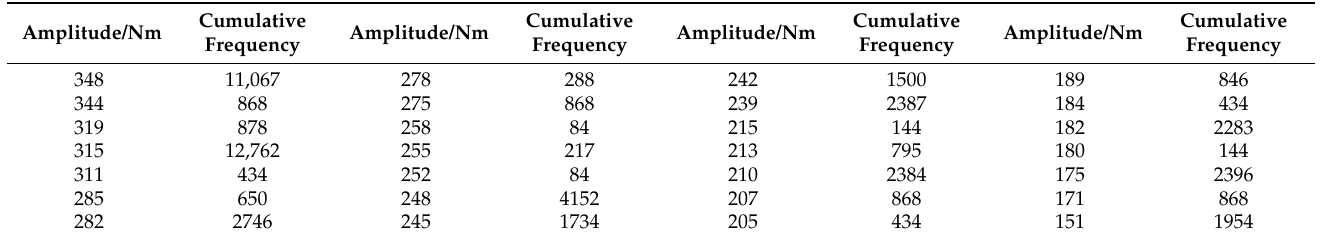
Table 5. One-dimensional load spectrum of drive motor positive torque